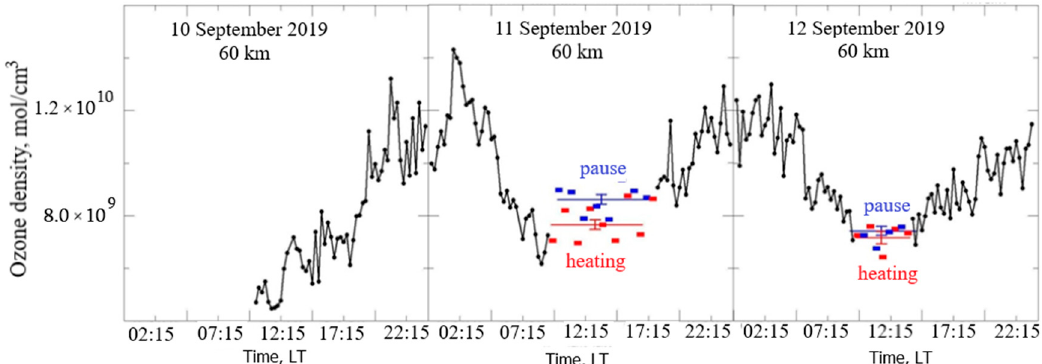
Figure 2. Temporal variations of the ozone density during from 11 September 2019 to 12 September 2019. Each black dot is obtained for the corresponding intensity of the ozone spectral line measured with an accumulation time of 15 min. Red and blue short strips show ozone density values averaged over each heating and pause session.